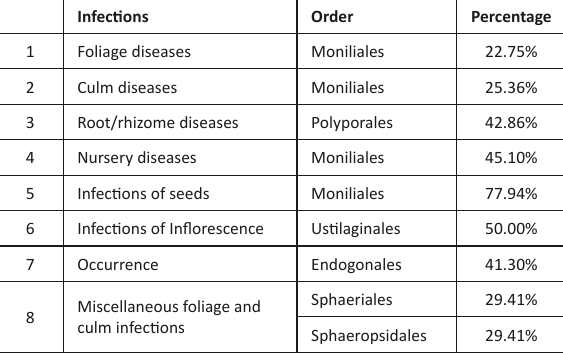
Table 4. Infections and the order in which highest percentage of pathogens